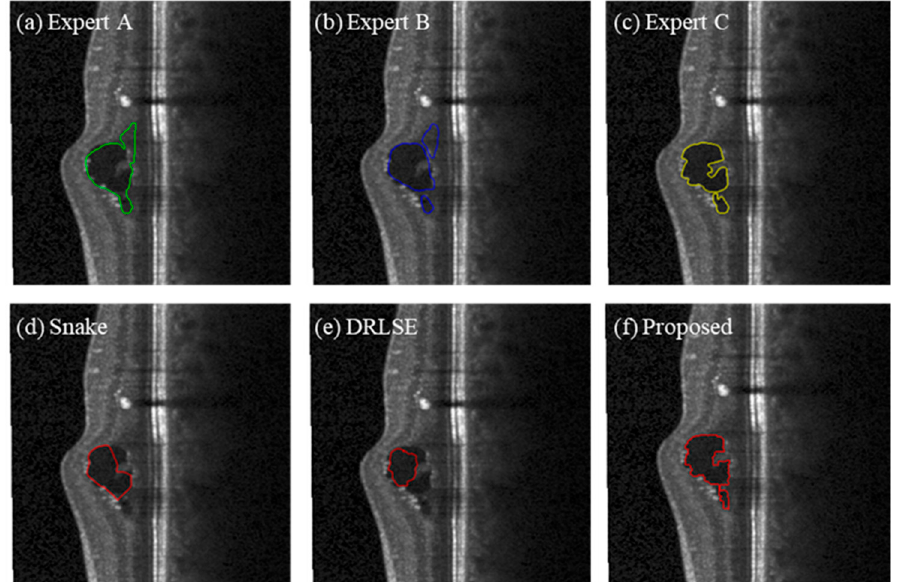
Figure 6. Comparison of algorithm segmentation results, ( a – c ) the results of expert manual segmentation, ( d ) the segmentation result of Snake active contour model algorithm, ( e ) the segmentation result of DRLSE algorithm, ( f ) the result of the proposed algorithm’s segmentation.